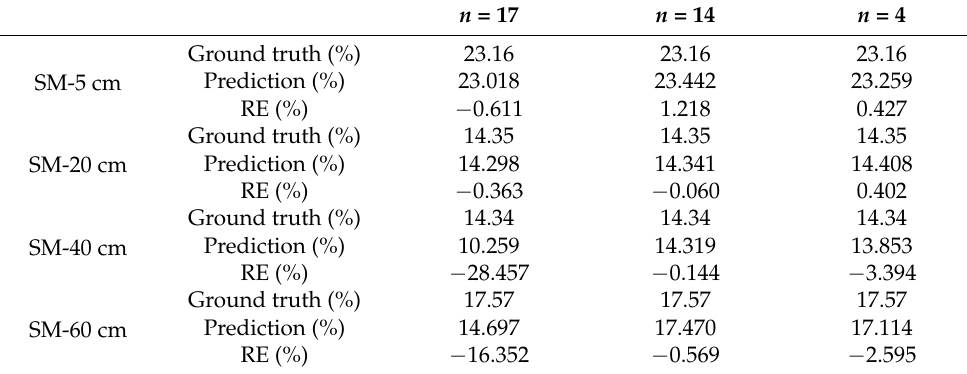
Figure 6. Comparison of prediction errors of different environmental factors. Table 10. Prediction results of DataA at different depths with a different number of environmental factors.